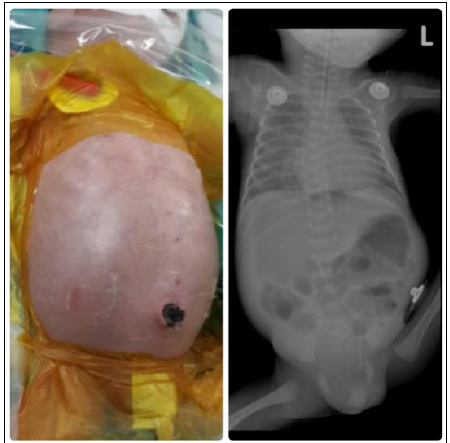
Figure 1: The abdominal characteristics and the radiograph of the baby at six days of age with distension of the abdomen and pneumoperitoneum.